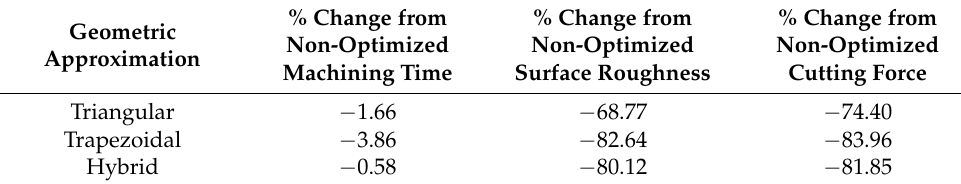
Table 5. Cutting force objective prioritization results.